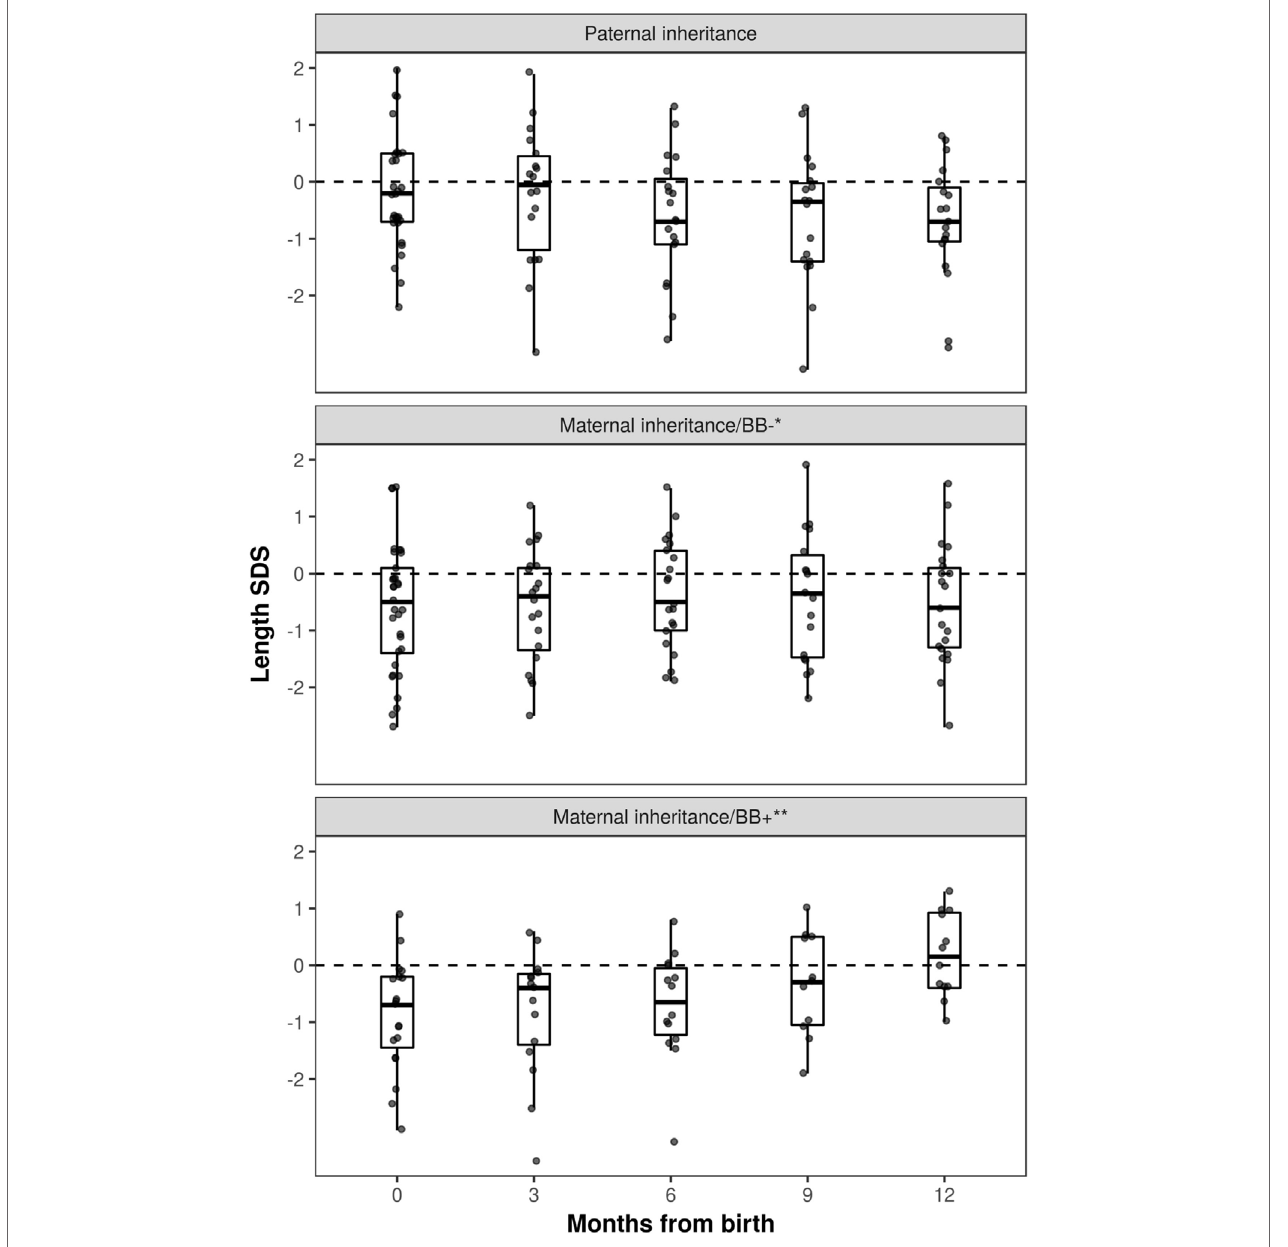
FigUre 2 | Length standard deviation score (SDS) during the first year of life in long QT syndrome 1 patients. Patients with maternal inheritance of KCNQ1 mutation and prenatal beta blocker exposure were shorter than those with paternal inheritance at birth ( P < 0.05), and displayed significant catch-up growth during the first year of life ( Δ 0.08 SDS/month, P = 0.004). *No beta blocker exposure during pregnancy; **prenatal beta blocker